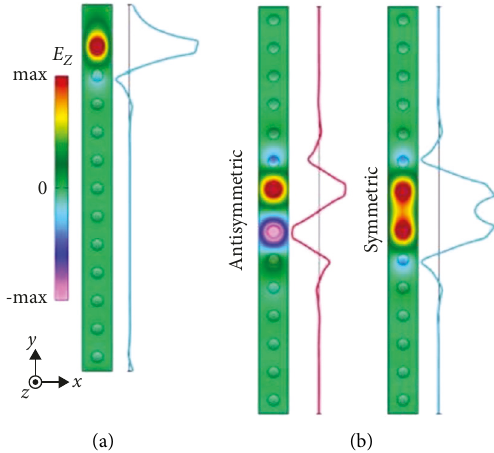
Figure 3: (Color online) modal properties of the SB of an isolated PC surface (a) and two interacting surfaces (b) at ω n 0 annular ends. The plots on the right depict the variation of E z along the corresponding vertical bisectors of